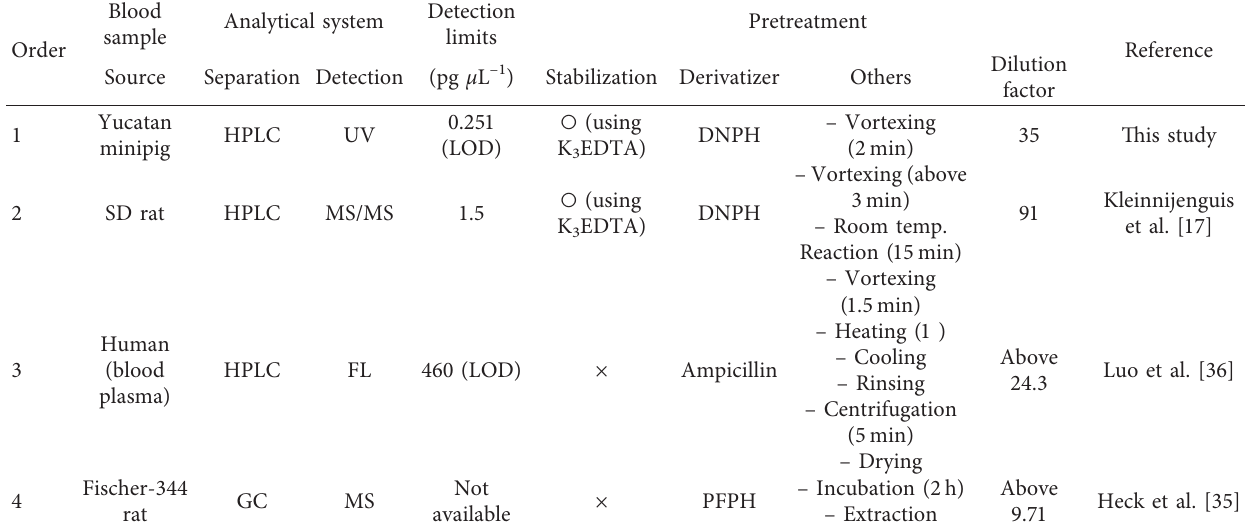
Table 3: Overview of the parameters for the analysis of FA in